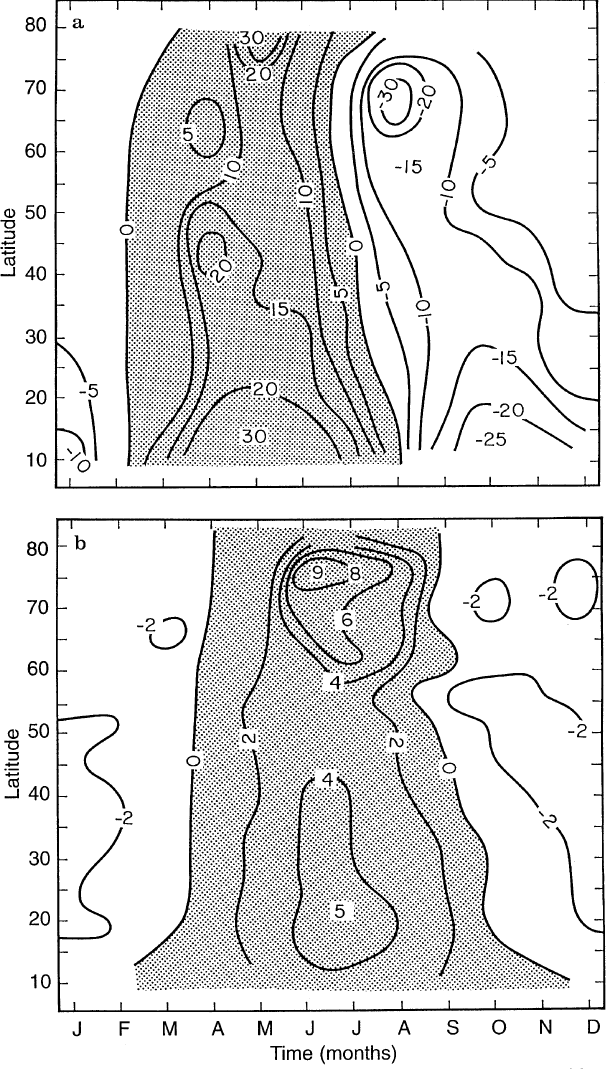
Fig. 4. a Zonally averaged continental ground temperature anomalies and b sea surface temperature anomalies resulting from orbital variations for 4 kyears AP (isotherms in 0.1 ° C)